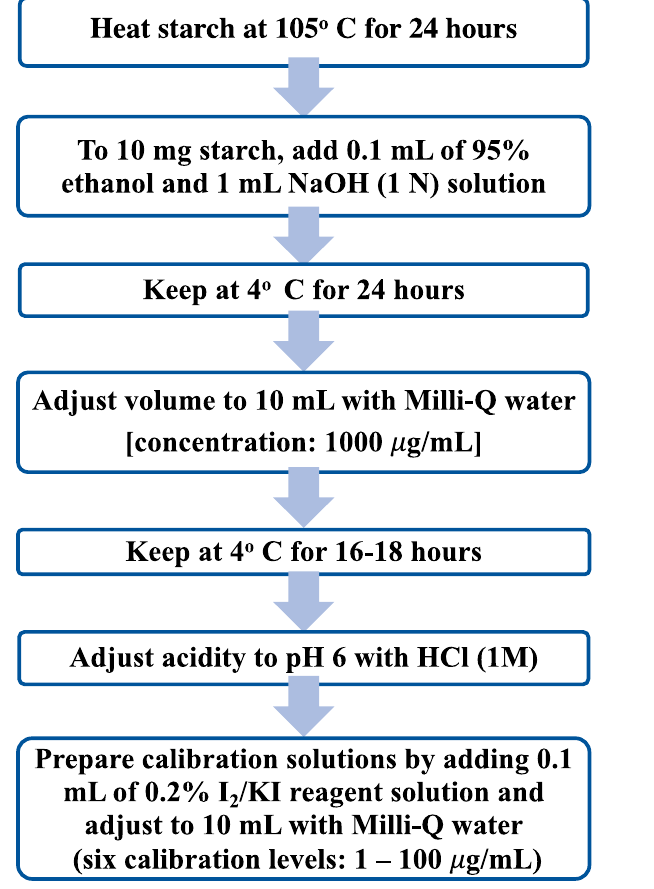
Figure 1. Optimized procedure of starch preparation for amylose–iodine complex spectrophotometry analysis.